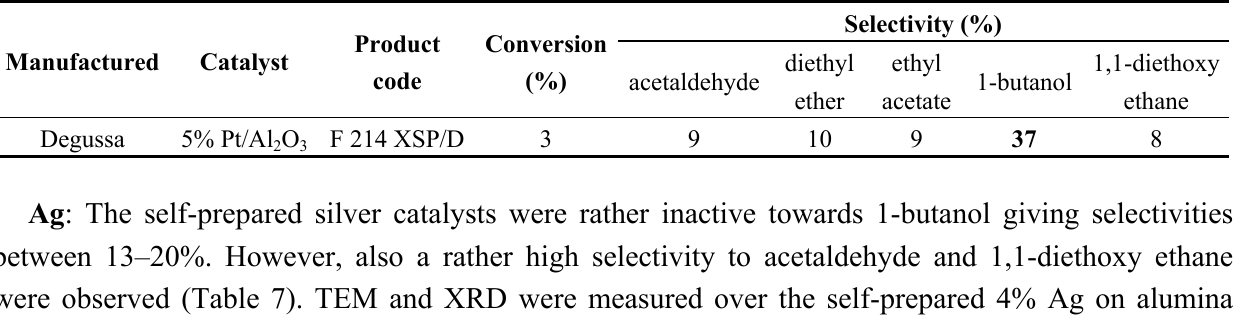
Table 6. Results obtained with alumina supported Pt catalyst.